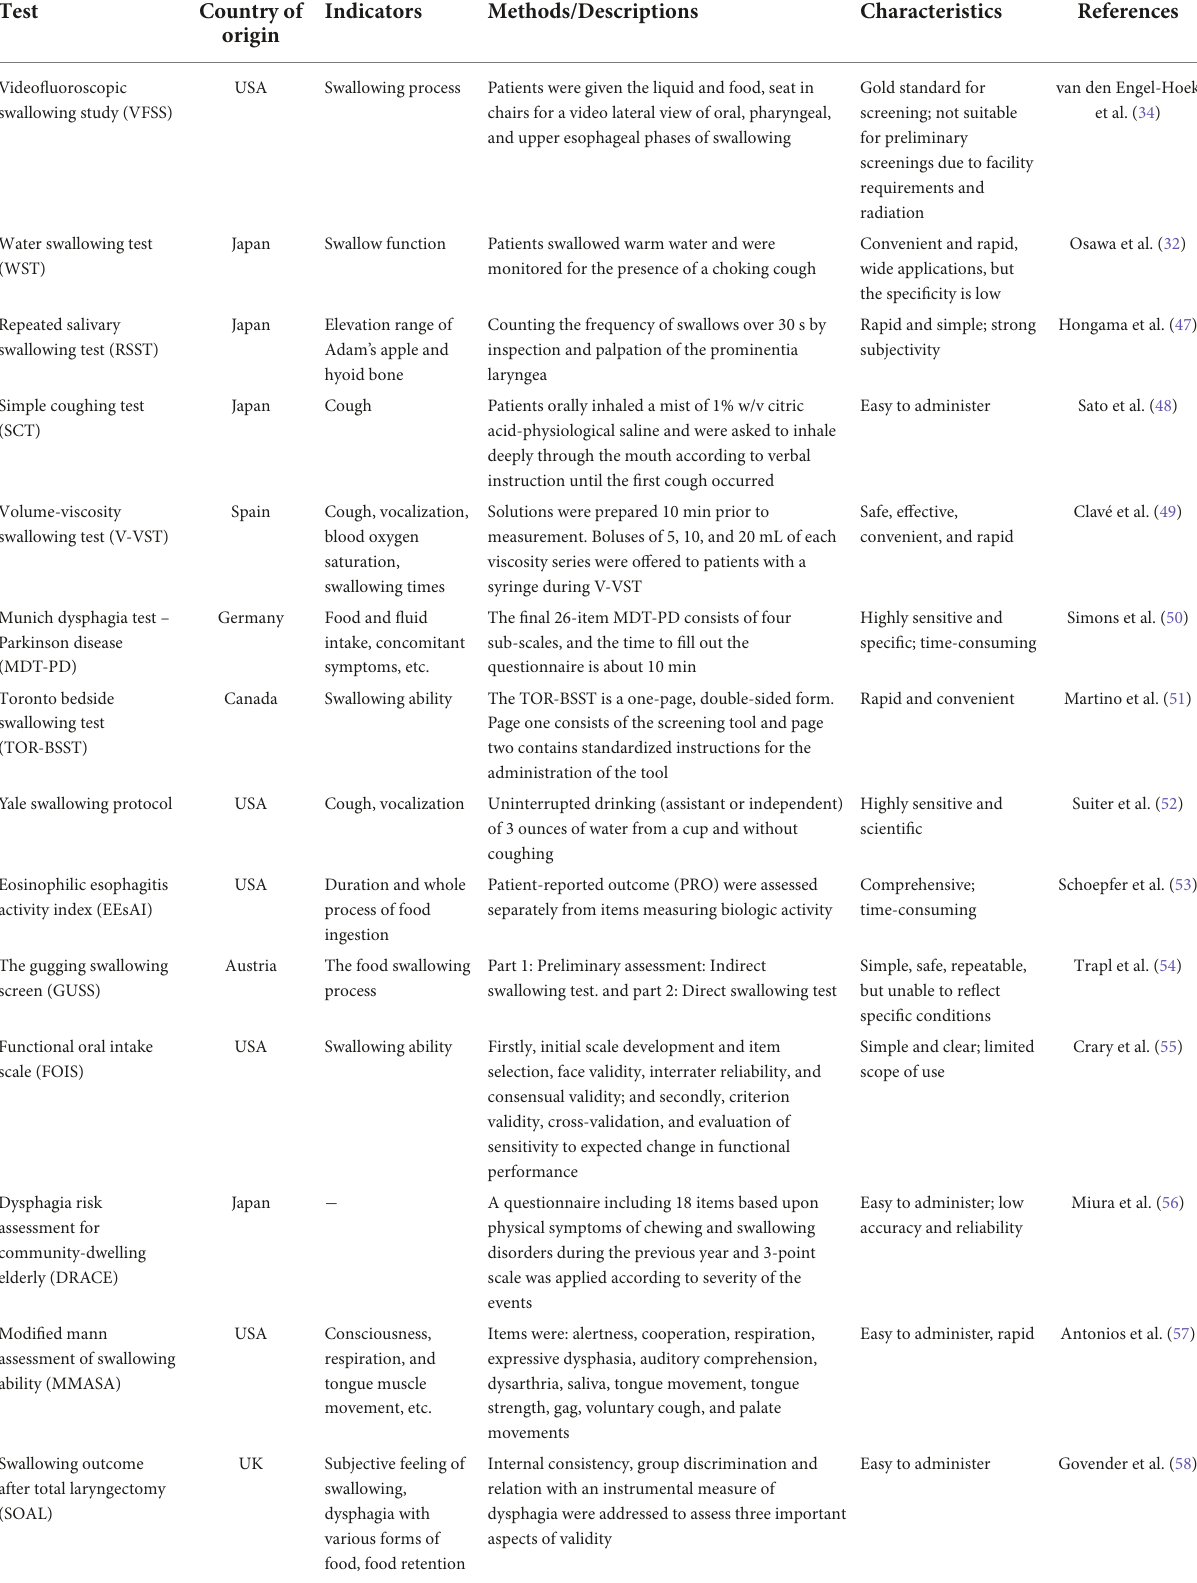
TABLE 1 Common screening and assessment tools for